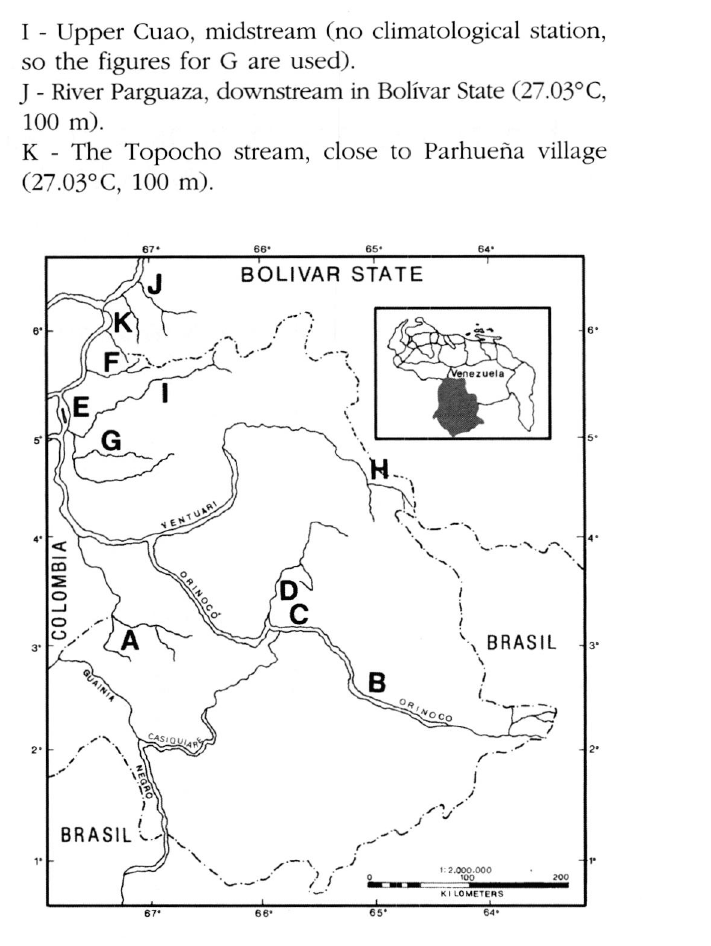
Fig. 1. - Regions where the study was carried out. A) Temi-Atacavi rivers. B) Upper Orinoco. C) Cejal. D) Cunucunuma river. E) Isla Raton. F) Cataniapo river. G) Cuao, Sipapo, and Atitana rivers. H) Upper Ventuari. I) Upper Cuao. J) Parguaza